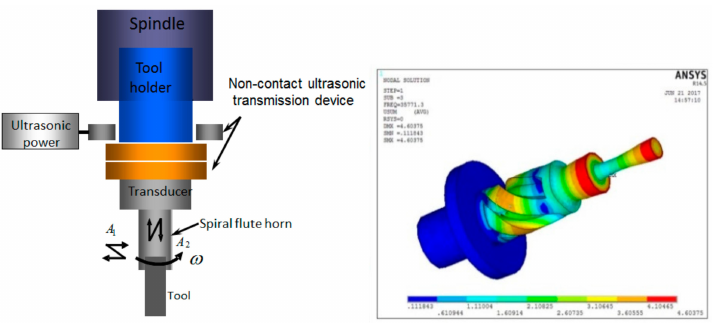
Figure 7. Longitudinal-torsional ultrasonic vibration system.